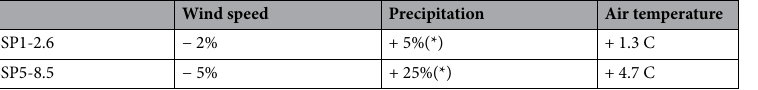
Table 1. End-of-century projected changes of present-day atmospheric conditions over the Gulf by the IPCC AR6 CMIP6 models. Two of the five IPCC scenarios reported here: SSP1-2.6 (sustainability) and SSP5-8.5 (fossil-fueled development) correspond, respectively, to a pervasive, world-wide curbing of GHG emission, and to continuing world-wide economic growth driven by an ever-increasing consumption of fossil fuels. (*) Individual CMIP6 models show a substantial and conflicting variability in precipitation change